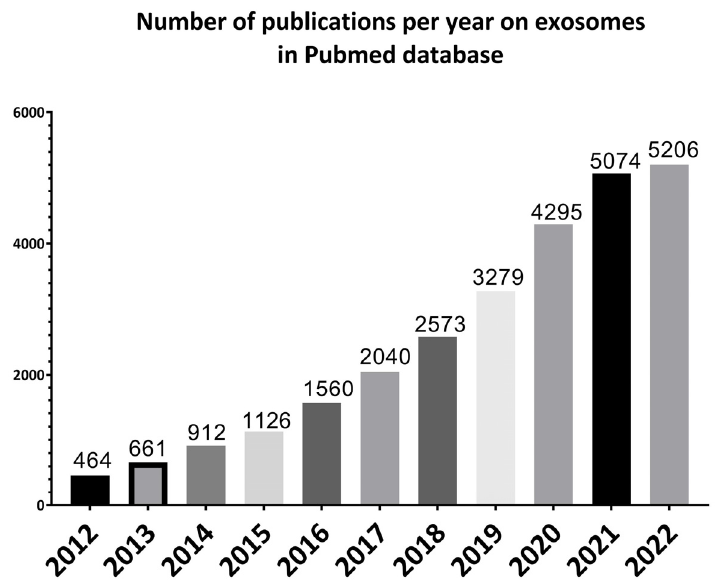
Figure 1. Illustrative bar charts representing the number of papers published per year on exosomes for the past 10 years from 2012 to 2022 using PubMed online